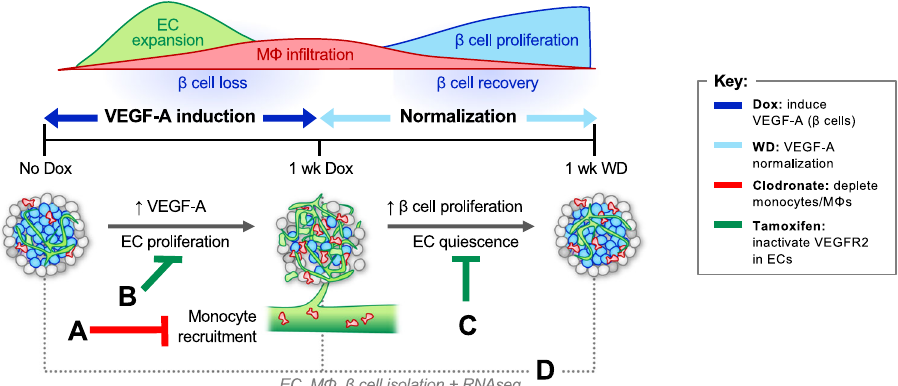
Fig. 1 The RIP-rtTA; Tet-O-VEGF-A ( β VEGF-A) model of β cell regeneration permits speci fi c modulation of the islet microenvironment. Induction of VEGF-A overexpression in β cells with doxycycline (Dox) causes rapid endothelial cell (EC) expansion, β cell death, and recruitment of circulating monocytes increasing the number of intra-islet macrophages (M Φ s). Once the Dox stimulus is removed, VEGF-A levels normalize and β cells undergo self-renewal 1 . To establish the role of M Φ s in β cell proliferation, monocytes and M Φ s were depleted with clodronate liposomes (scheme A). To determine whether proliferative intra-islet ECs were required for β cell loss, M Φ recruitment, and M Φ phenotype activation, an additional genetic construct was introduced to knockdown key signaling receptor VEGFR2 in ECs prior to VEGF-A induction (scheme B). To determine if VEGFR2 signaling in quiescent ECs contributes to β cell proliferation, VEGFR2 was inactivated in ECs during β cell recovery (scheme C). To identify cell-speci fi c transcriptome changes during β cell loss and recovery, populations of ECs, M Φ s, and β cells were isolated prior to and during VEGF-A induction, and after VEGF normalization (scheme D). For additional details, including mouse models utilized, see Supplementary Fig.